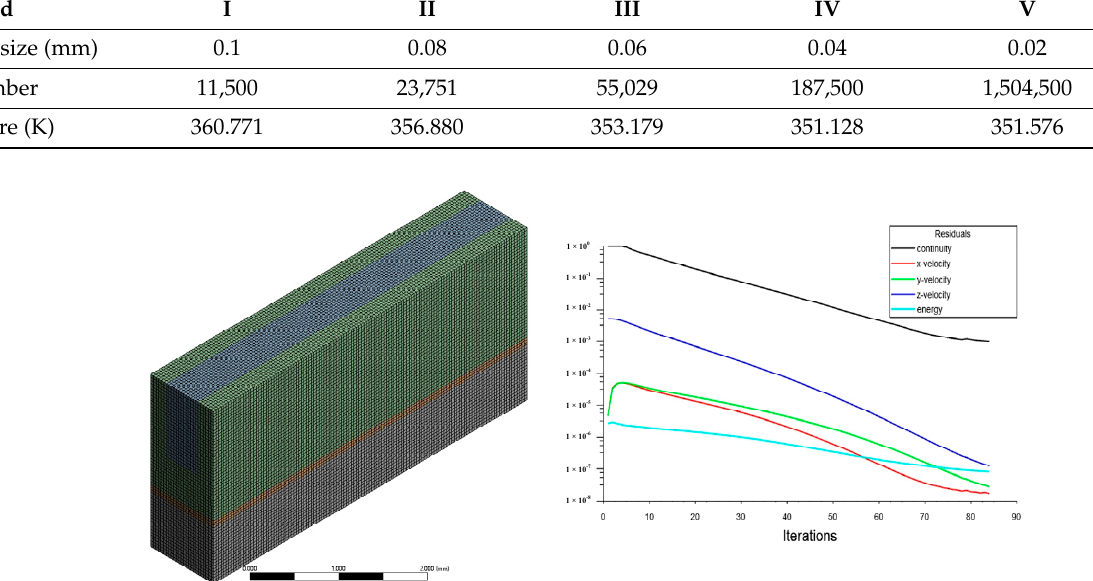
Figure 4. Meshed model and residuals.